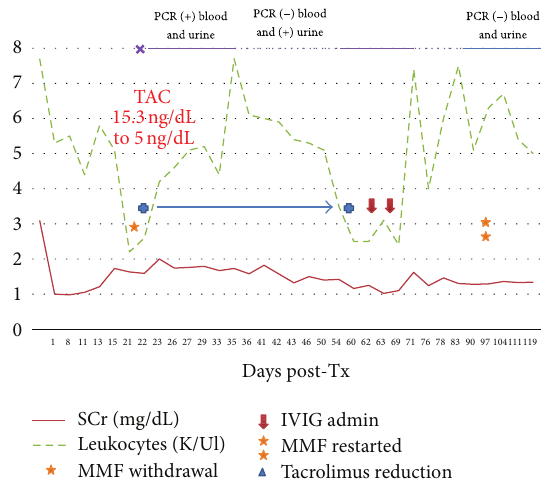
Figure 2: Case 1: correlation of SCr, leukocytes, and treatment administration.